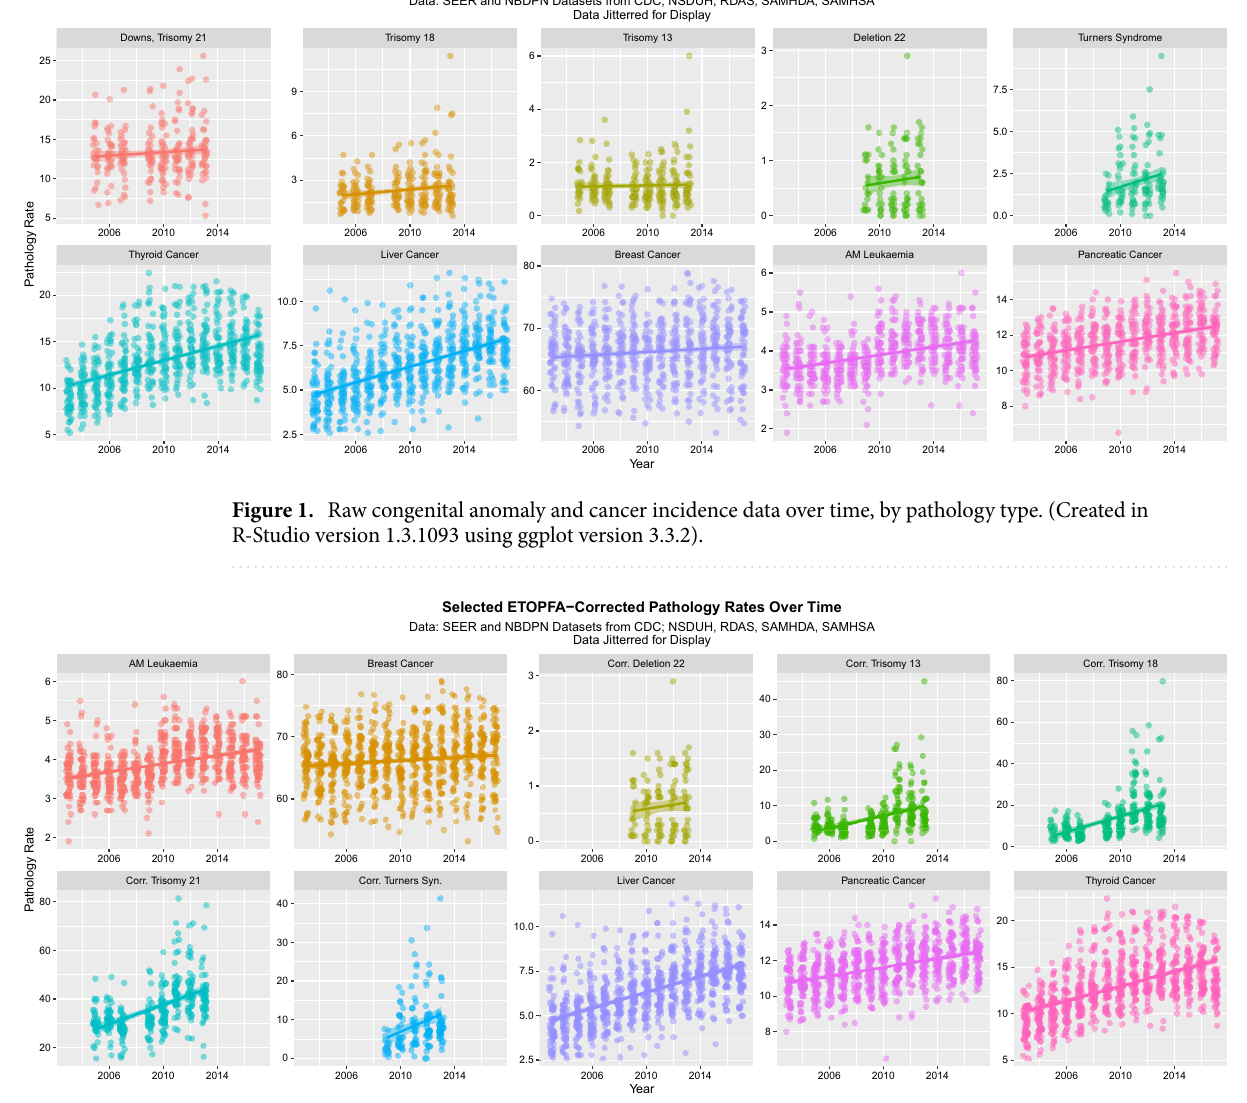
Figure 2. ETOPFA-corrected congenital anomaly and cancer incidence data as a function of THC exposure, by pathology type. (Created in R-Studio version 1.3.1093 using ggplot2 version